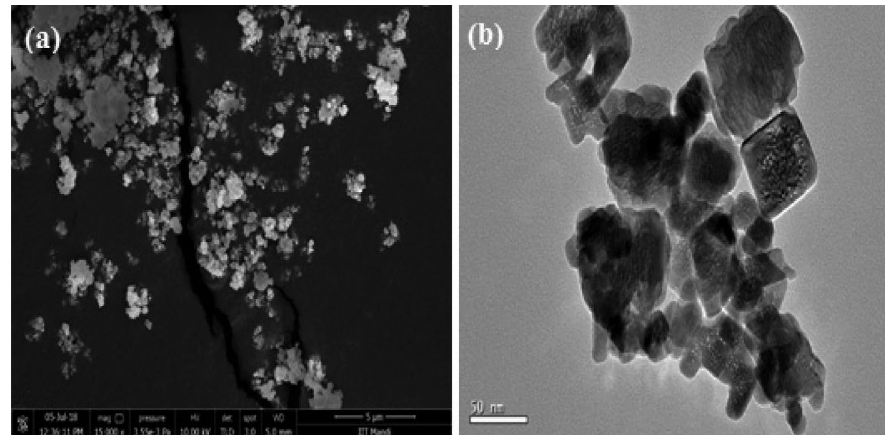
Figure 4. (a) SEM and (b) TEM images of YbPO 4 :Tb 3+ (SC)